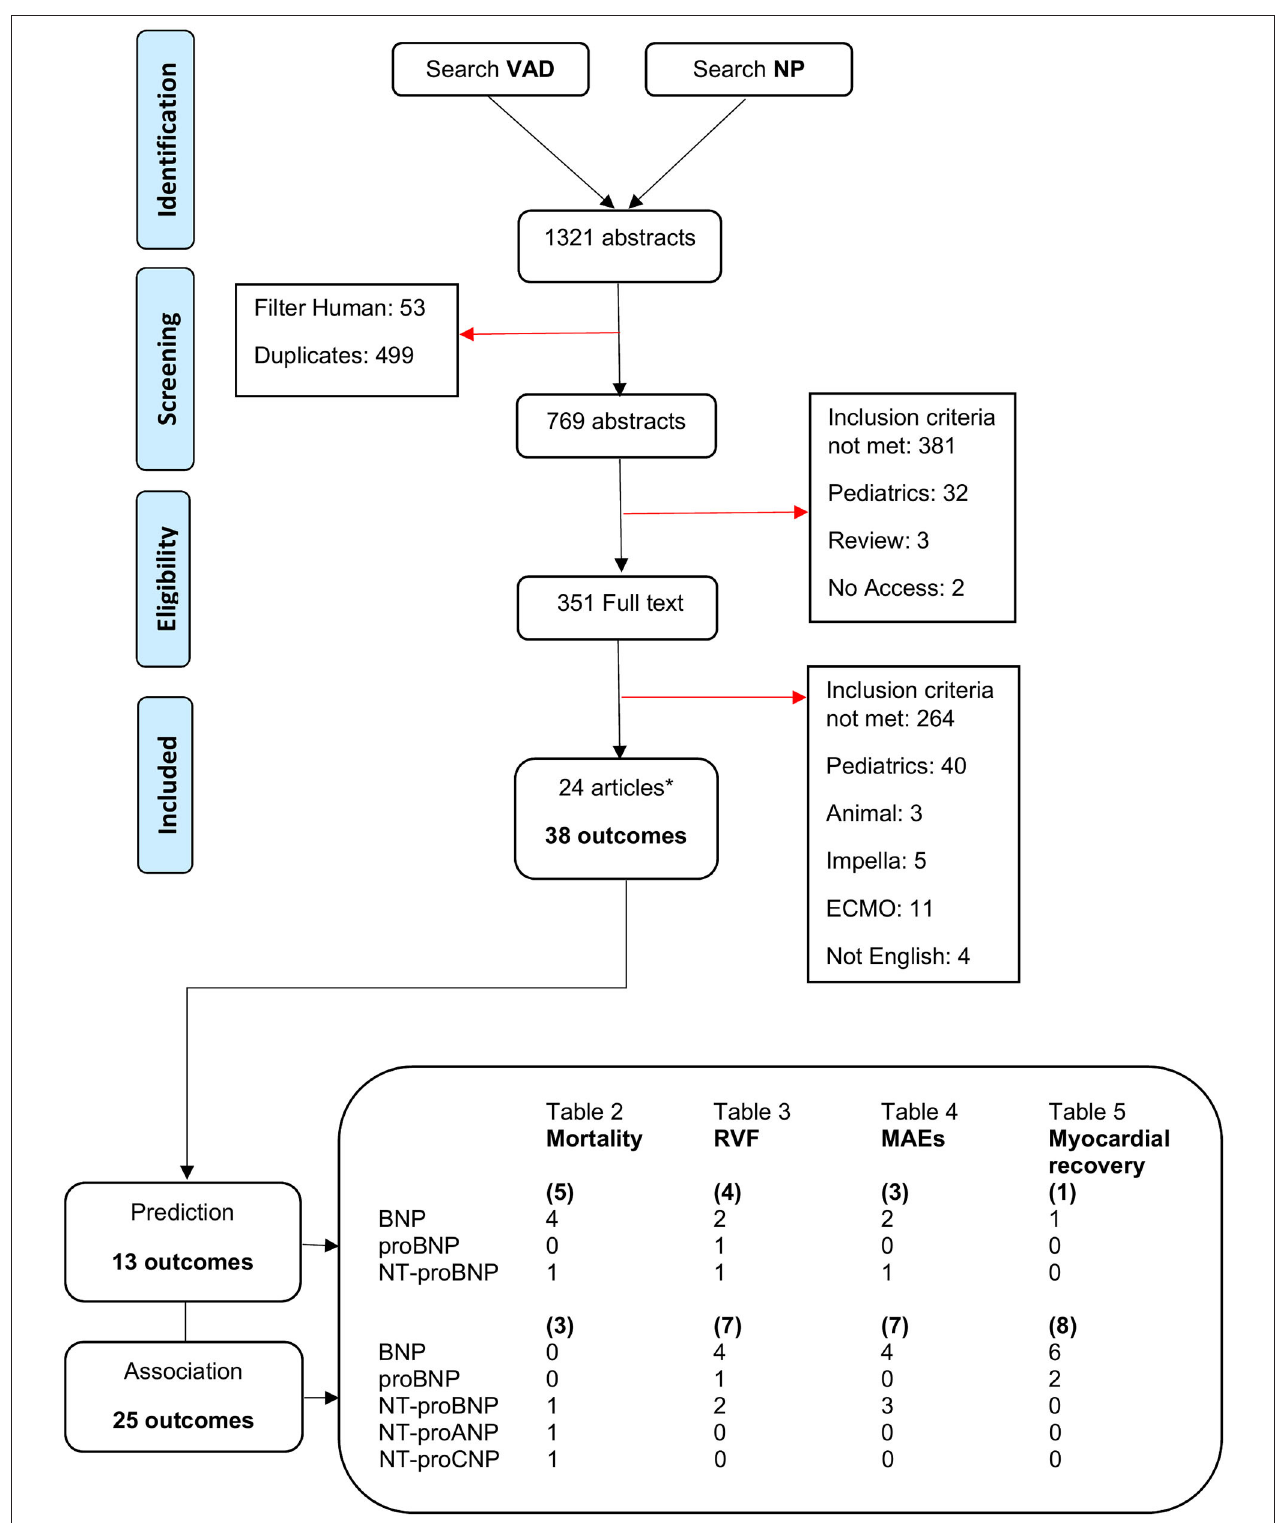
FIGURE 2 | PRISMA flow diagram for literature search and study selection process. *Several articles contain multiple circulating NP or outcomes. ANP, atrial natriuretic peptide; BNP, B-type natriuretic peptide; CNP, C-type natriuretic peptide; ECMO, extracorporeal membrane oxygenation; MAEs, major adverse events; NP, natriuretic peptide; NT-proBNP, N-terminal pro-BNP; RVF, right ventricular failure; VAD, ventricular assist device.